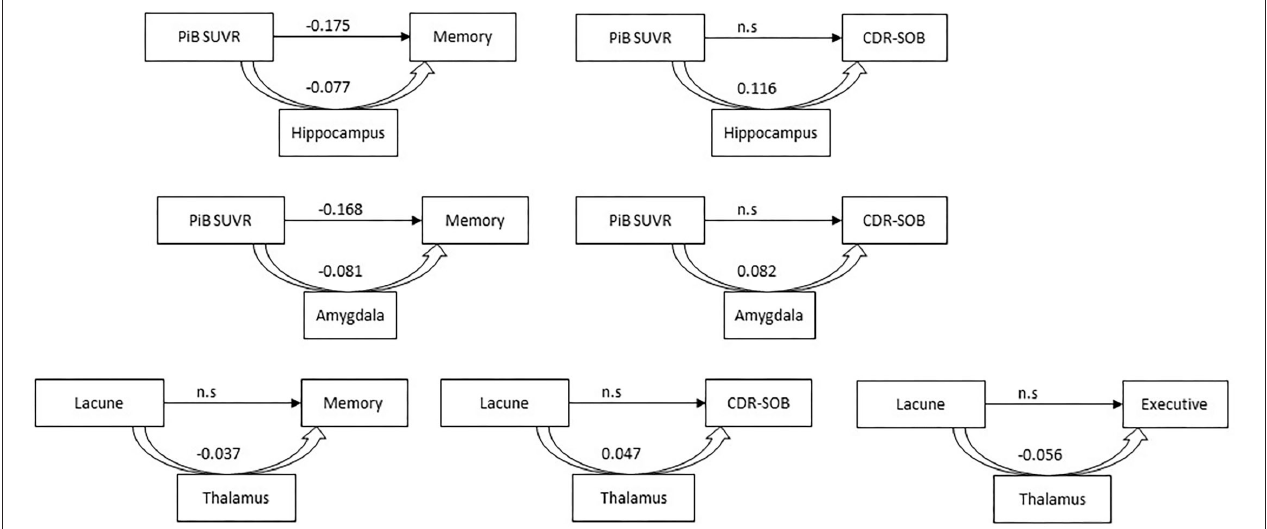
FIGURE 2 | Schema of a mediation model. Arrows mean direct effect between Pittsburg compound B (PiB) standard uptake value ratio (SUVR)/lacune and cognition. Curved arrows signify an indirect effect of subcortical structures between PiB SUVR/lacune and cognition. CDR-SOB, dementia rating scale sum of box; n.s, no significant; PiB, Pittsburgh compound B; SUVR, Standard uptake value ratio.